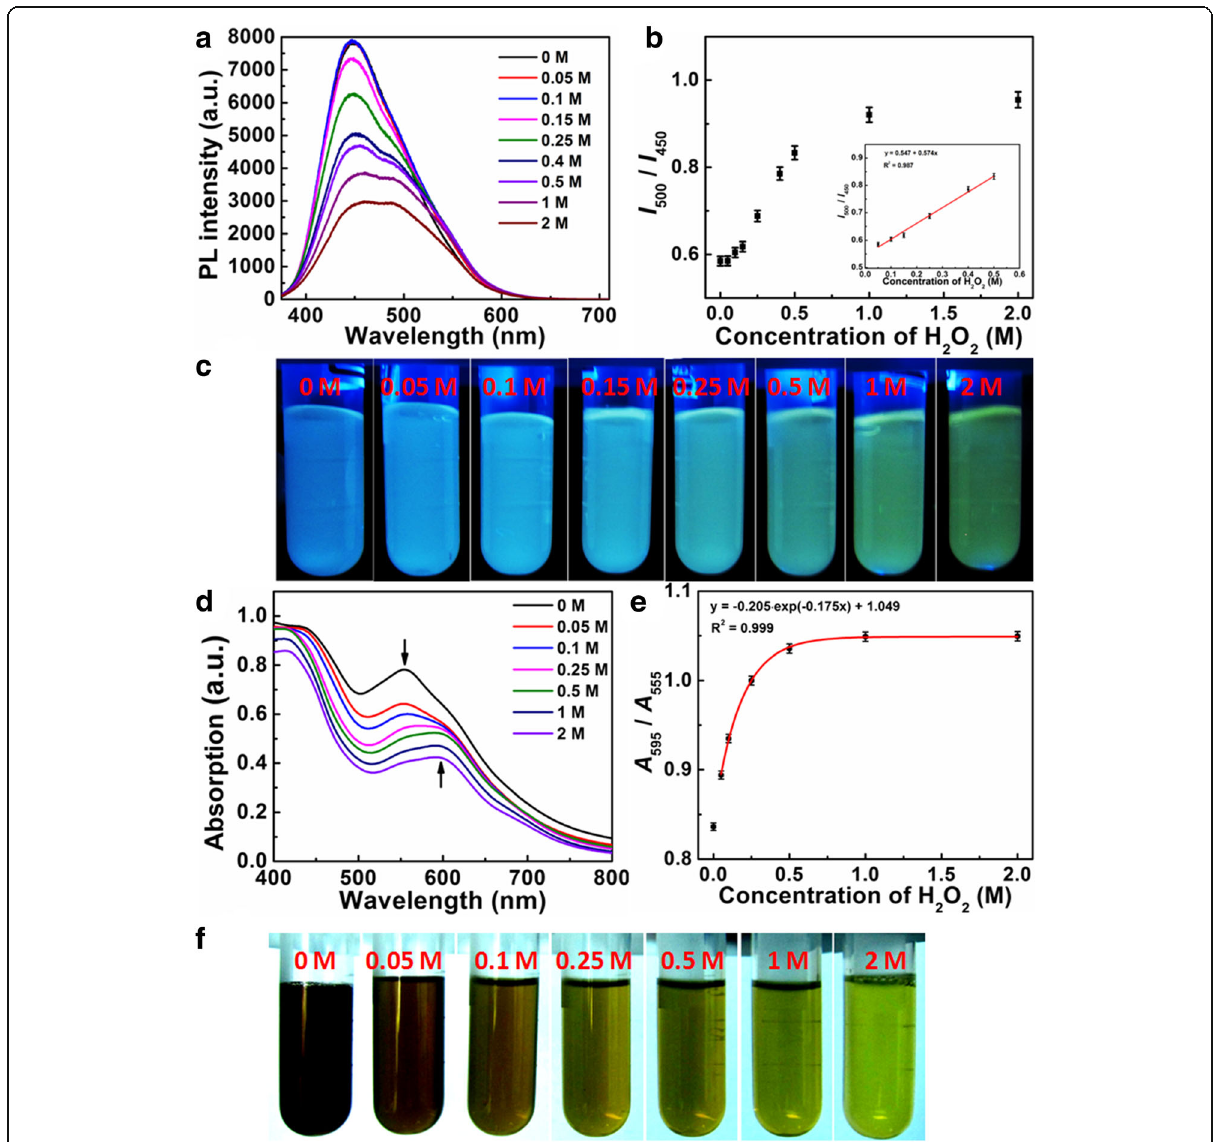
Fig. 4 a Fluorescence spectra of CDs in the presence of different H 2 O 2 concentrations. b Calibration curve of I 500 / I 450 of the CDs vs. H 2 O 2 concentration. Insets show the linear detection range of I 500 / I 450 of the CDs vs. H 2 O 2 concentration. c Photographic images of the fluorescence CD solution under different concentrations of H 2 O 2 . d UV-Vis spectra of CDs in the presence of different H 2 O 2 concentrations. e Calibration curve of A 595 / A 555 of the CDs vs. H 2 O 2 concentration. f Photographic images of the CD solution under different concentrations of H 2 O